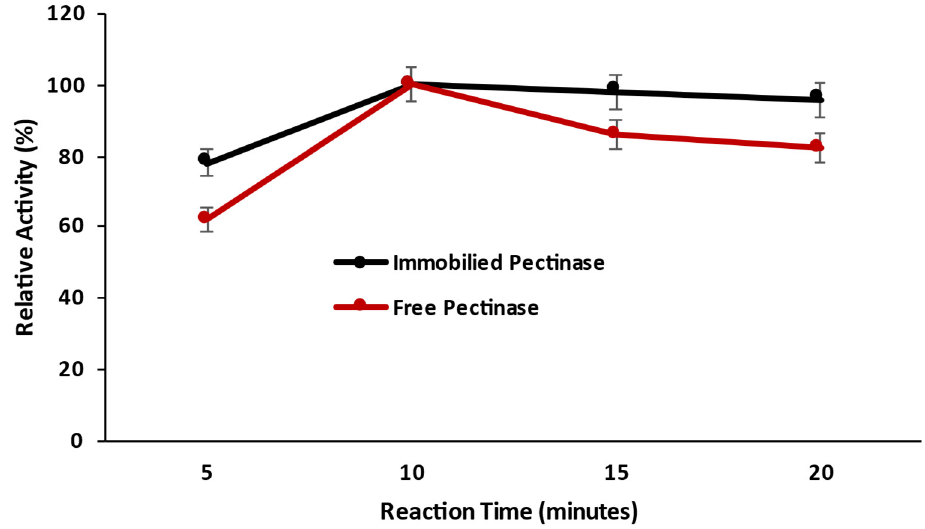
Figure 6. Effect of time on the catalytic activity of pectinase immobilized magnetic iron oxide